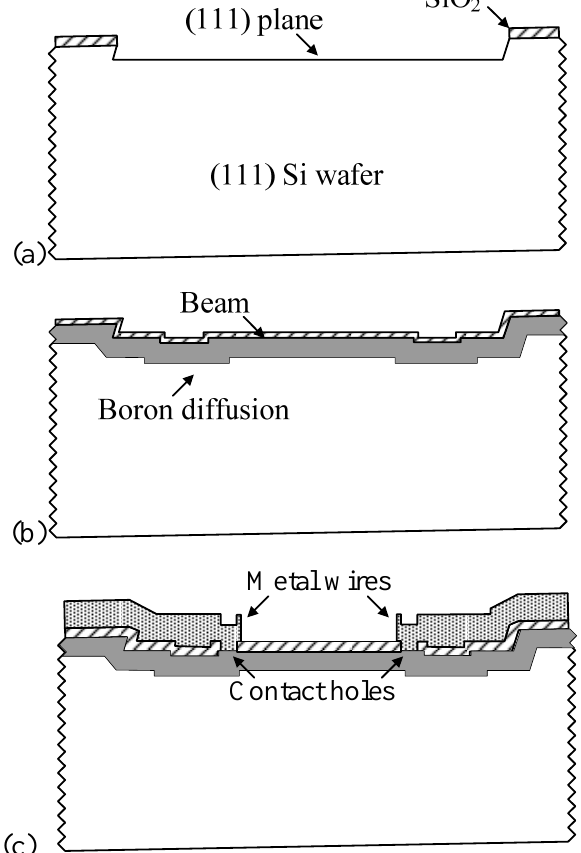
Figure 3 . Process flow. (a) KOH pre-etching. (b) Beam patterning and boron